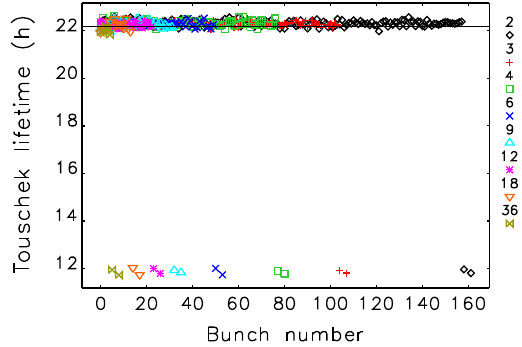
FIG. 19. Touschek lifetime for unique bunches for fill patterns with various numbers of two-bunch gaps in a 324-bunch pattern. The solid line shows the lifetime for a uniform 324-bunch fill.